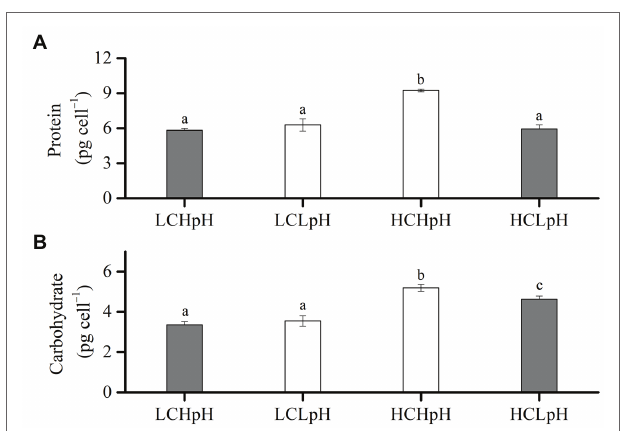
FIGURE 4 | (A) Cellular protein content and (B) cellular carbohydrate content of E. huxleyi RCC1266 under the LCHpH (gray), LCLpH, HCHpH, and HCLpH (gray) treatments. Different letters (a, b, c) in each panel represent significant differences between four treatments (Tukey Post hoc , p < 0.05). For more information, please see Figure 1